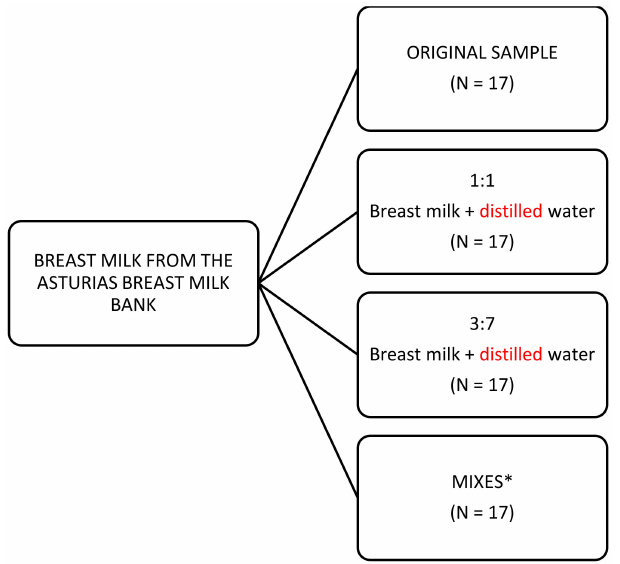
Figure 1. Scheme for battery sample preparation (N = 68). * Mixes (1:1) of following samples: 16 + 17, 10 + 4, 6 + 1, 7 + 1, 2 + 17, 3 + 16, 4 + 15, 5 + 1, 6 + 13, 7 + 12, 8 + 11, 9 + 10, 2 + 3, 5 + 8, 9 + 11, 12 + 13, and 3 +